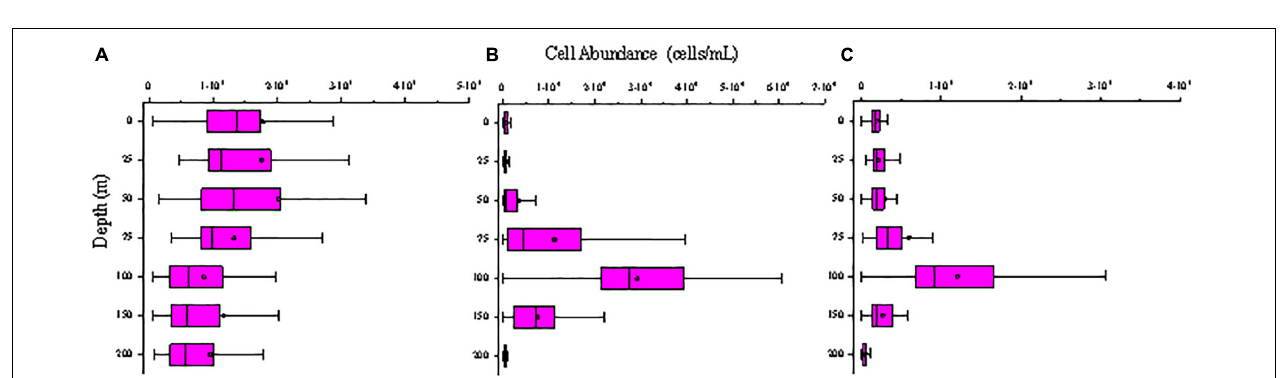
FIGURE 6 | Section profile of abundances of picophytoplankton along (A–D) transects (cells/mL).